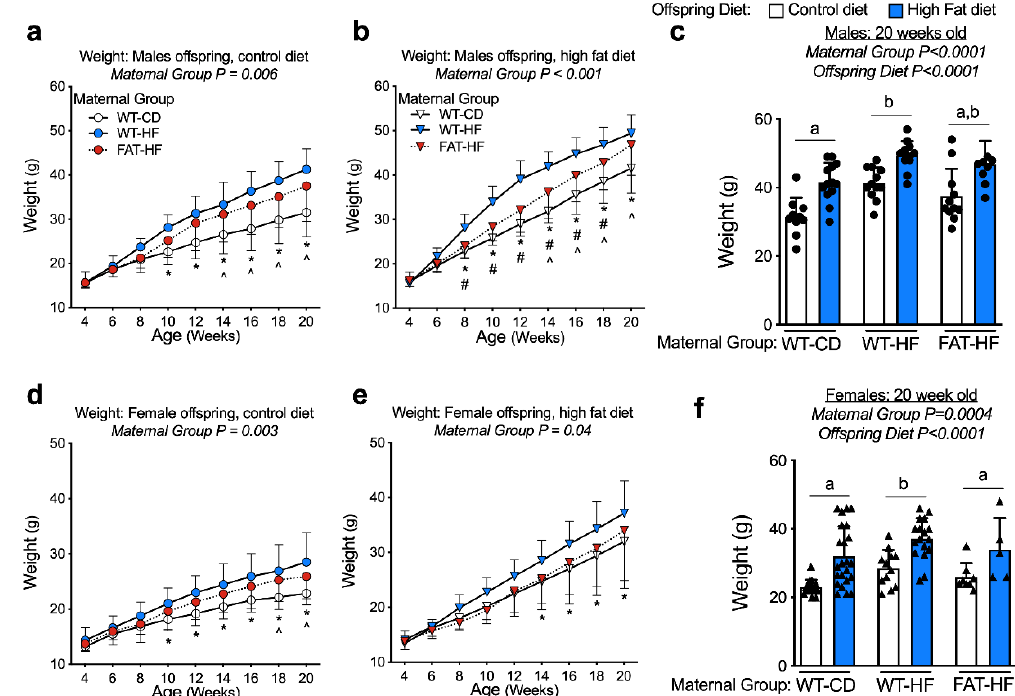
Figure 3. Maternal fat-1 transgene partially protects offspring from excess weight gain. Weight was measured from weaning to 20 wks in offspring of WT dams fed a control diet (WT-CD), or offspring of WT or fat-1 hemizygous dams fed a high-fat diet (WT-HF and FAT-HF, respectively) throughout pregnancy and lactation. All offspring were WT and were weaned to control or high-fat diet for male ( a – c ) or female ( d – f ) offspring. For males, n ≥ 10 per group. For females, n ≥ 5 per group. All data are presented as mean ± SD. * p < 0.05 for di ff erence between WT-CD and WT-HF. ˆ p < 0.05 for di ff erence between WT-CD and FAT-HF. # p < 0.05 for difference between WT-HF and FAT-HF. Different letters above bars denote statistically significant differences between those bars at p < 0.05 significance level. Insulin tolerance tests were performed with bolus i.p. insulin injection at 20 wks of age in the